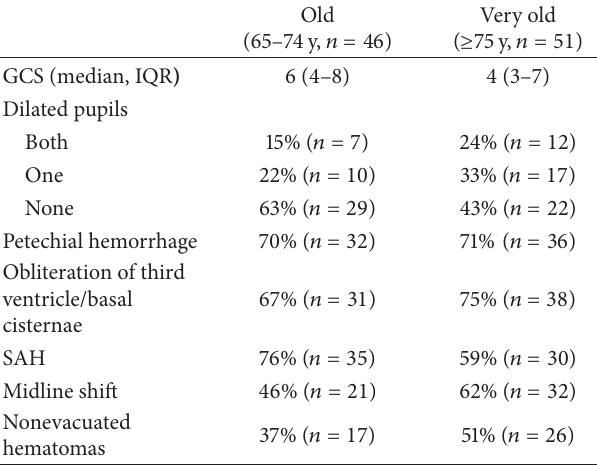
Table 2: Distribution of injury severity and CT based findings in the old and very old